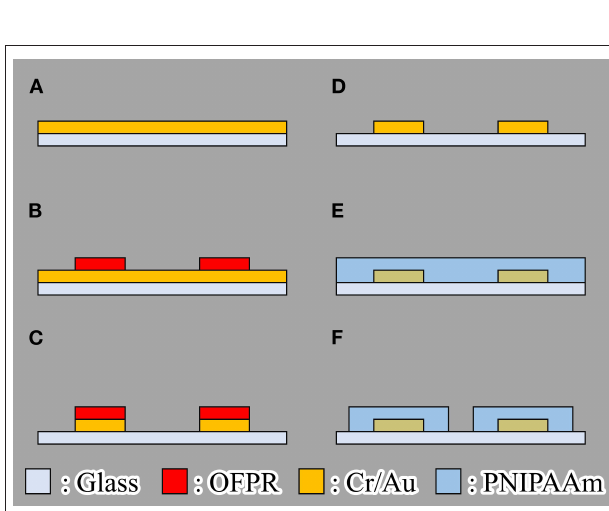
FIGURE 3 | Experimental setup of the light-driven gel actuator system.